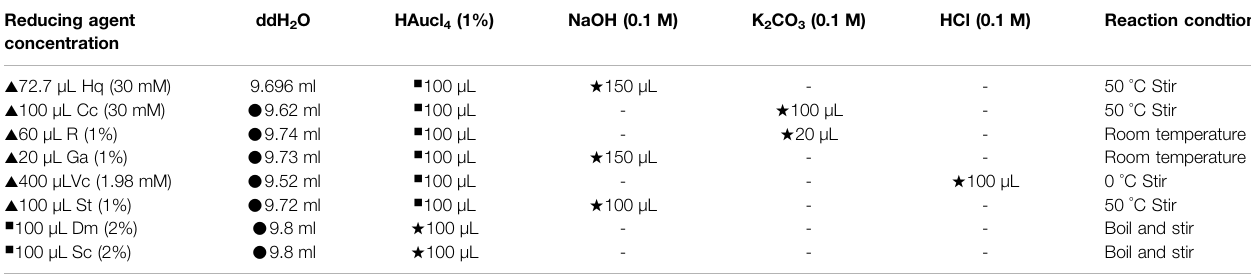
Note(addition order of reagents C + ■ ▲ ◆ ).